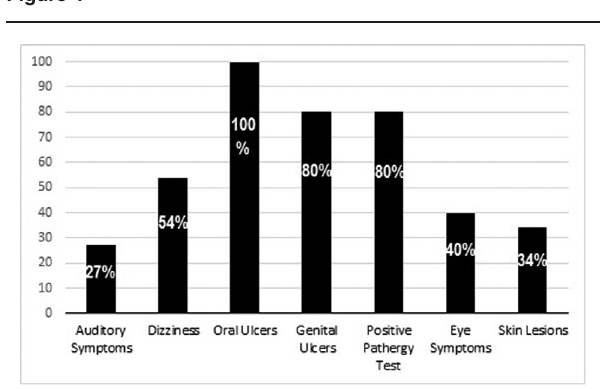
posturography; HFA, high-frequency audiometry.